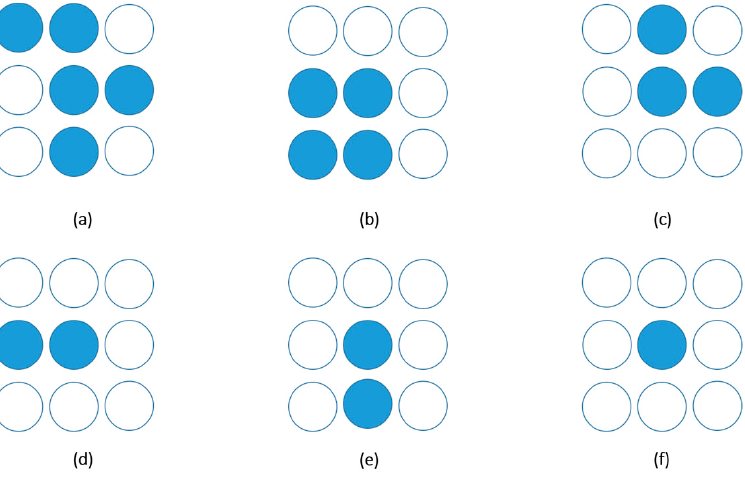
Figure 7. Outliers: ( a – e ) show points with connected domains; ( f ) shows outliers. In the experiment, in order to obtain better results, we adjusted the judgment criterion and experimented on the cases of 4-neighborhoods and 8-neighborhoods. We removed the data with different SNRs for 4-neighborhood outliers and 8-neighborhood outliers once, and the results are shown in Figures 8 and 9. We found that selecting no other points in the 4-neighborhood as outliers removed more noise. Subsequently, an ablation experiment was performed to compare the effects of the two criteria on the detection results. From Table 1, it can be found that the improvement in the detection results when using four points as the judgment criterion is more obvious, so the isolated noise is removed in this method in subsequent